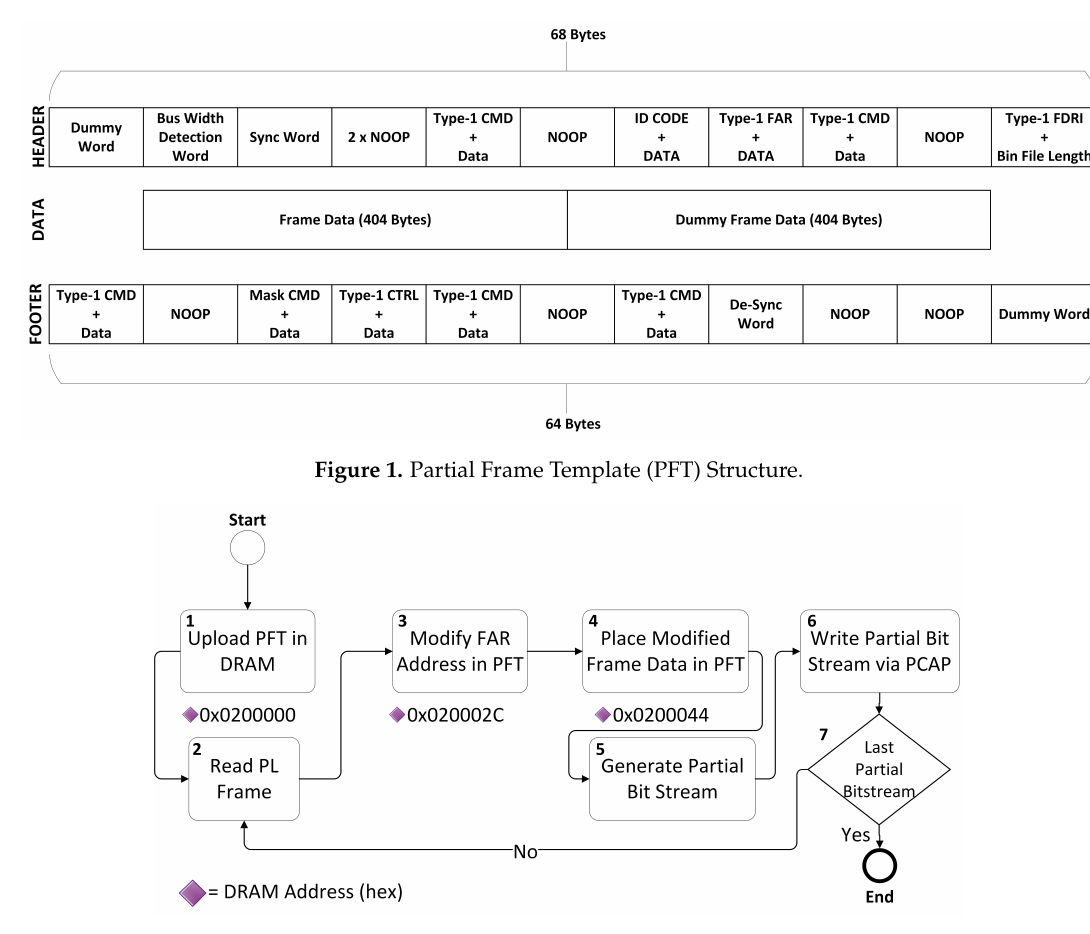
Figure 2. Partial Frame Template (PFT)